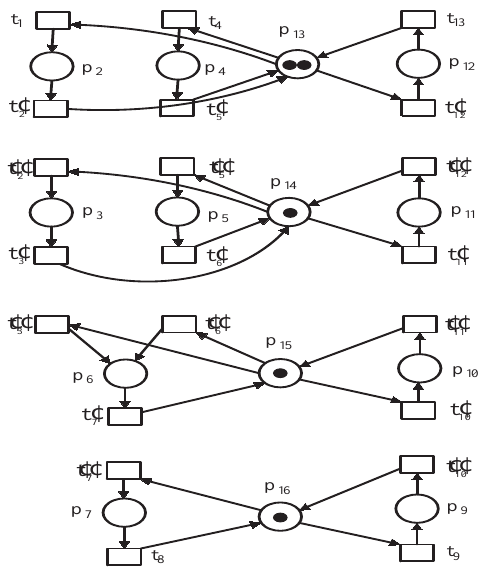
Figure 9. A subnet model N = ( N (cid:48) , M 0 ) with N (cid:48) = ( P (cid:48) , T (cid:48) , F (cid:48) ) .